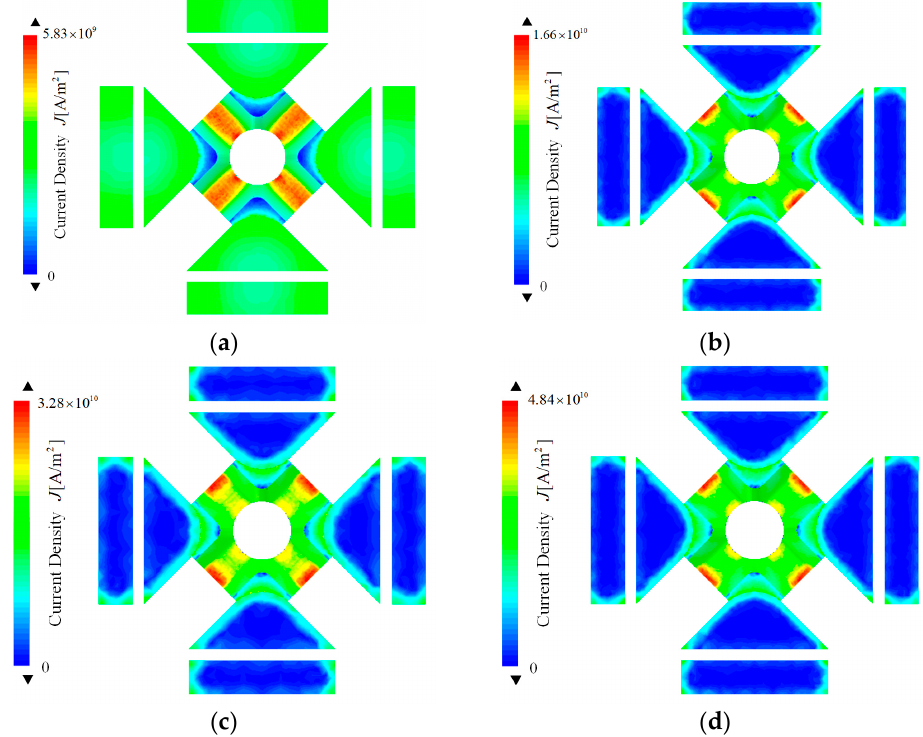
Figure 10. Skin depth at different current frequencies: ( a ) 2000; ( b ) 3000; ( c ) 4000; ( d ) 6000 Hz.